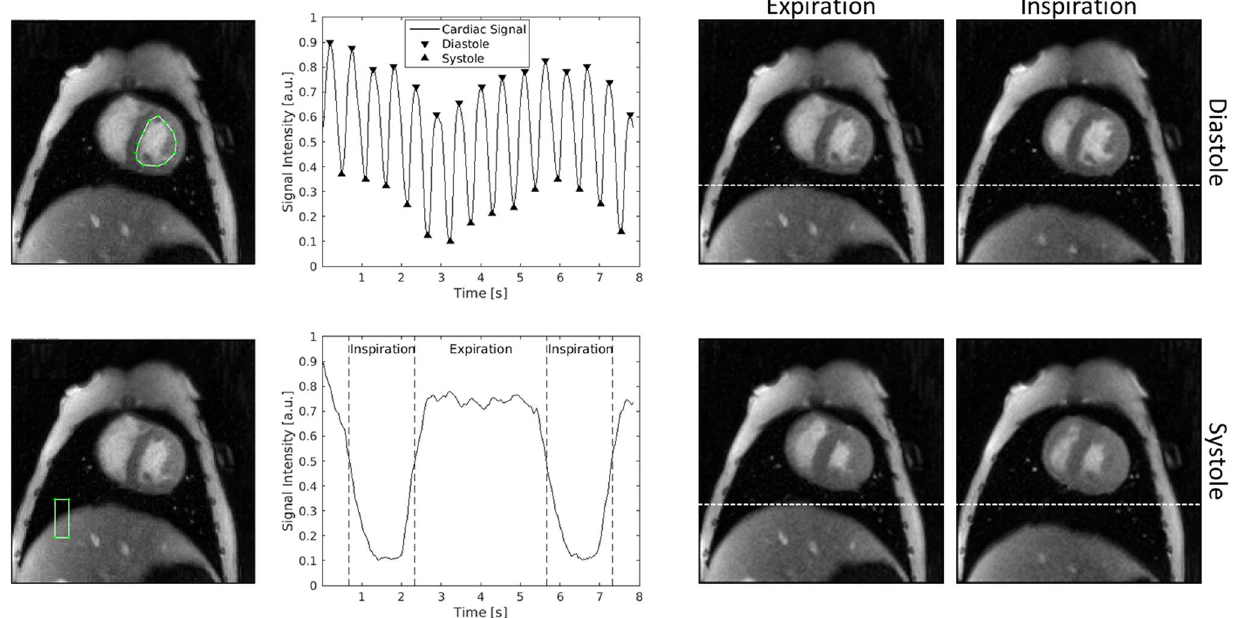
Figure 5. Semi-automatic extraction of cardiorespiratory phases. The cardiorespiratory phase was extracted from signal-time curves of region of interests manually drawn in the left ventricle (top left) and at the lung-liver interface (bottom left). The diastolic and systolic phases (black arrows) were extracted from the signal-time curve of the left ventricle using a peak detection algorithm. The inspiration and expiration are detected based on thresholds defined by the respiratory signal (separated by dashed lines). Representative end-diastolic and end- systolic images obtained during inspiration and expiration are shown on the right. The movement of the liver due to respiration is clearly visible (dashed